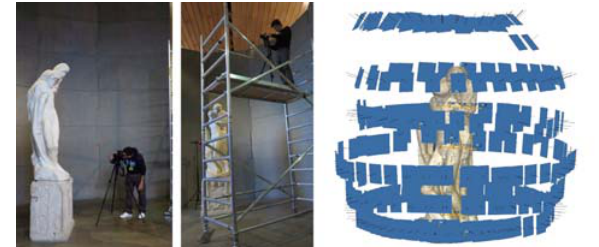
Figure 5. On the left: the photogrammetric survey from the ground and from above with a scaffold. On the right: the geometry of acquisition.